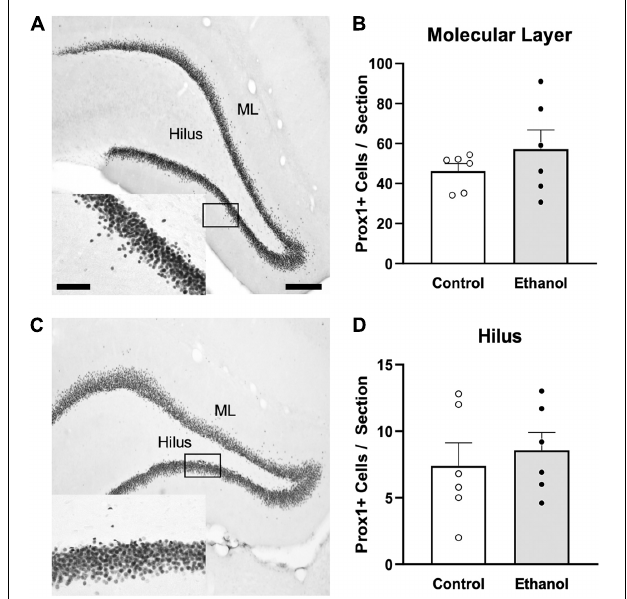
FIGURE 5 | Ectopic granule cells were not observed in the DG of female rats 14 days following ethanol exposure. Representative images show Prox1 immunoreactivity in a control [ (A) n = 6] and ethanol-treated [ (C) n = 6] rat. Prior alcohol exposure had no impact on Prox1+ ectopic cells in the molecular layer (B) or hilus (D) of adult female rats. Data are mean ± SEM. Symbols represent individual data points. Scale bars = 200 µ m; 60 µ m